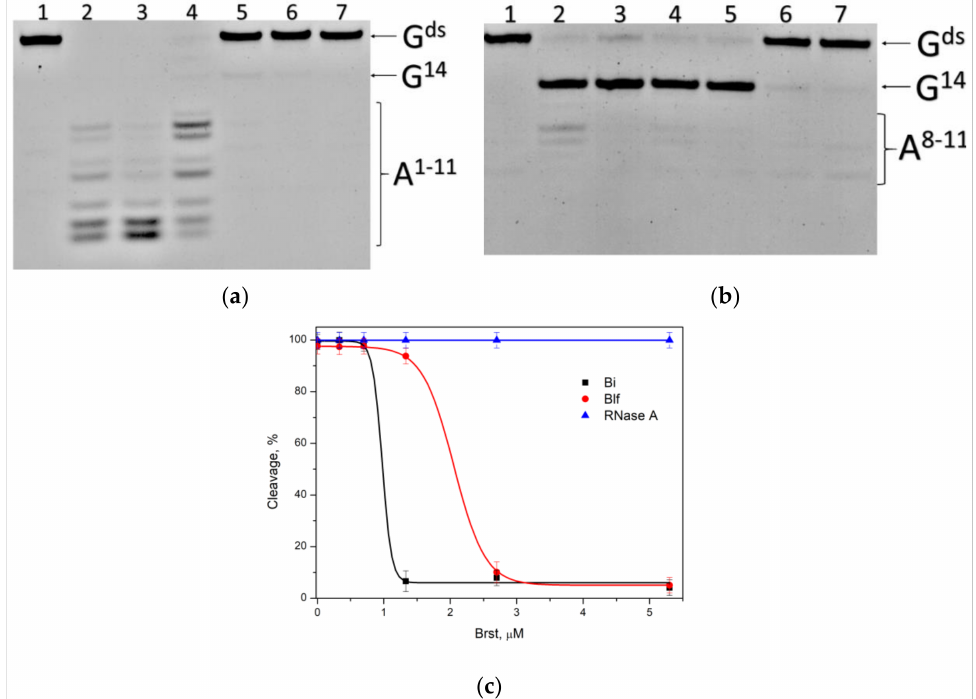
Figure 5. Electrophoretic separation of reaction products upon cleavage of the G ds substrate by homologous RNases in the presence of barstar. ( a ) Reaction performed by binase, ( b ) Reaction performed by balifase. Lanes: (1) G ds + 5.3 мк M barstar; (2) G ds + Enzyme; (3) G ds + Enzyme + 0.3 мк M barstar; (4) G ds + Enzyme + 0.7 мк M barstar; (5) G ds + Enzyme + 1.3 мк M barstar; (6) G ds + Enzyme + 2.7 мк M barstar; (7) G ds + Enzyme + 5.3 мк M barstar. Substrate concentration was 1 µ M, enzyme concentration was 0.7 µ M. ( c ) Dependence of the degree of the G ds degradation by binase (Bi), balifase (Blf) and RNase A on the barstar